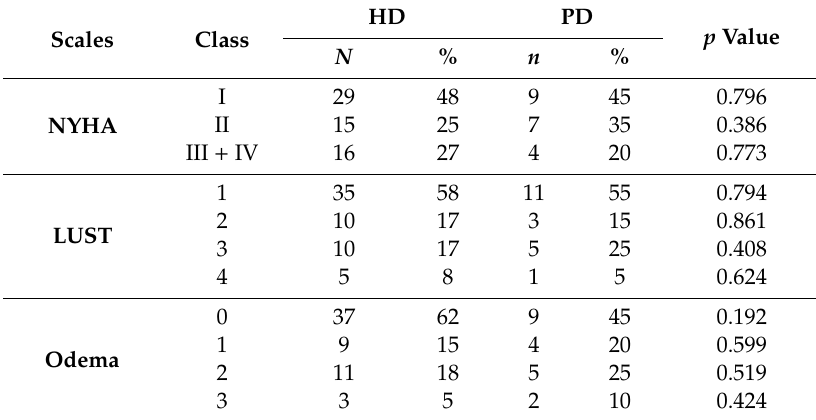
Table 7. Results of the clinical assessment of patients.